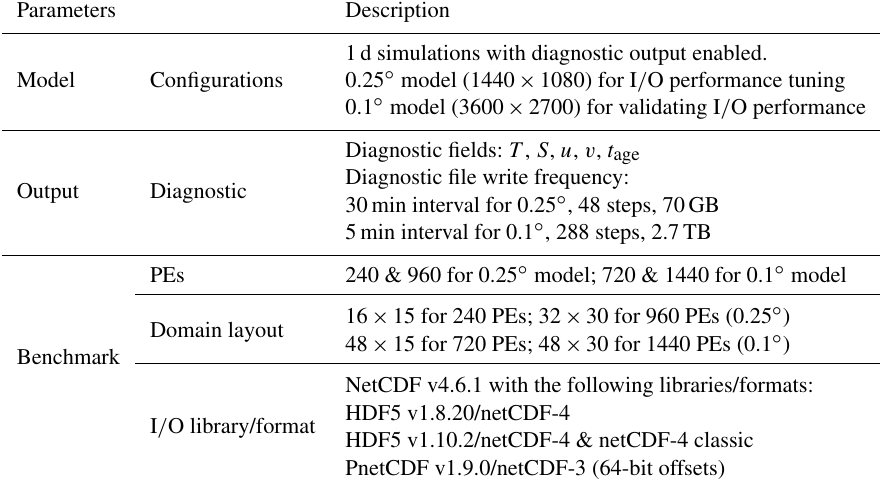
Table 3. The parallel I / O performance benchmark configurations.